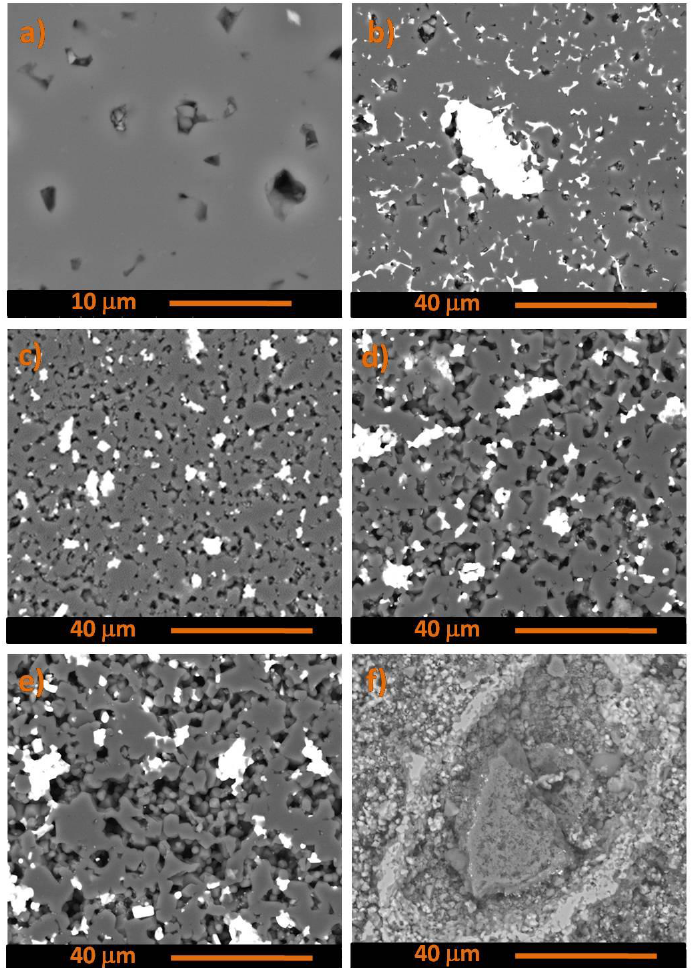
Figure 8. The SEM images showing the microstructures of the composites B 4 C: ( a ) 0% TiSi 2 , ( b ) 5% TiSi 2 , ( c ) 10% TiSi 2 , ( d ) 15% TiSi 2 , ( e ) 20% TiSi 2 , ( f ) stochiometric addition of TiSi 2 .